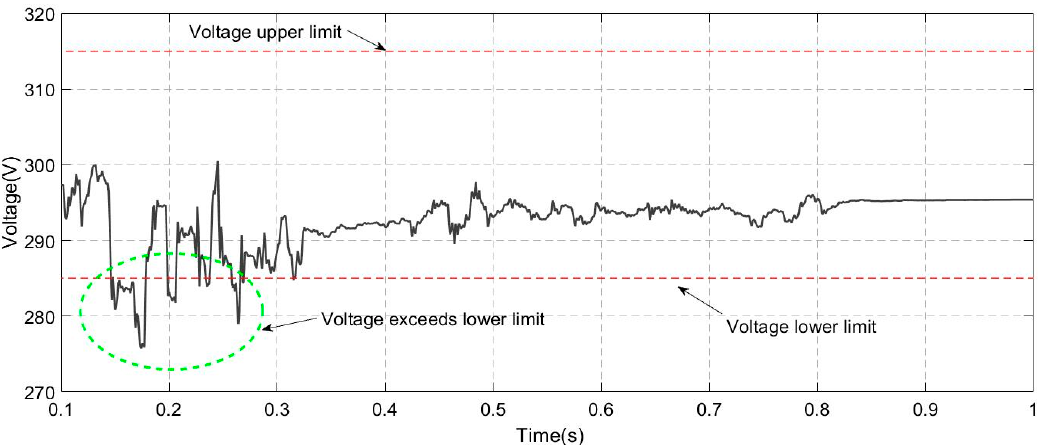
Figure 5. The waveform of V PCC under power factor control strategy.